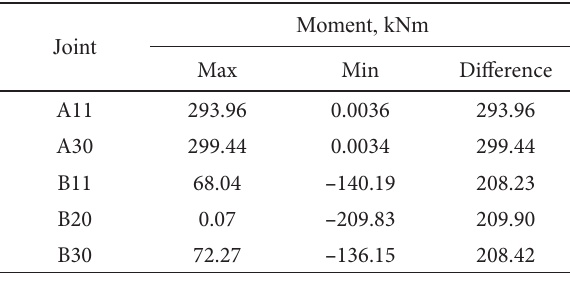
Fig. 3. Max-min moment envelop transferred to each joint under static moving load Table 1. Maximum and minimum moment transferred to welded joint under static moving load